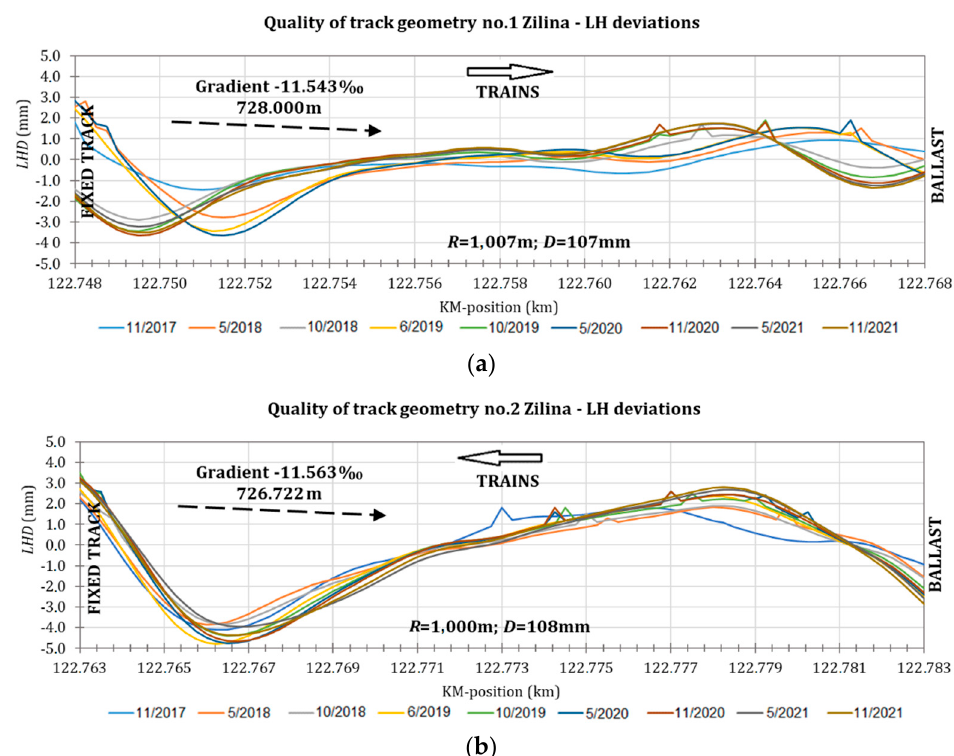
Figure 11. Quality of track geometry—longitudinal height deviations (LHD) of the transition zone, toward “Zilina”: ( a ) Track axis no. 1; ( b ) Track axis no. 2.